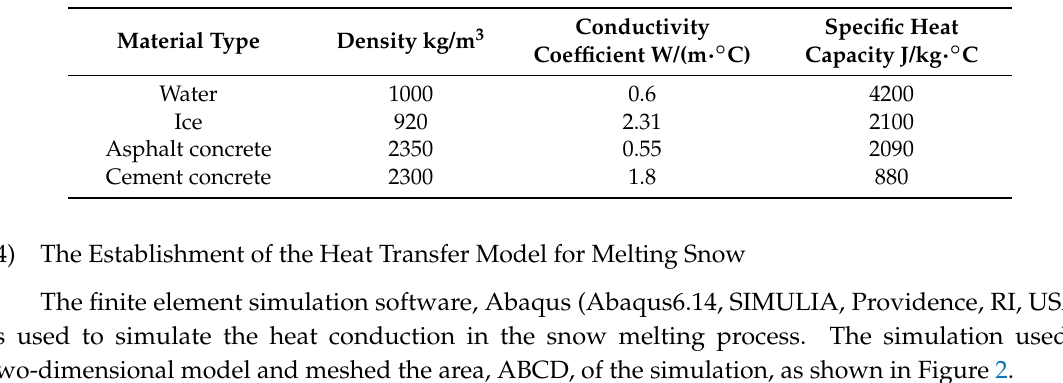
Table 2. Parameters related to temperature characteristics of materials.